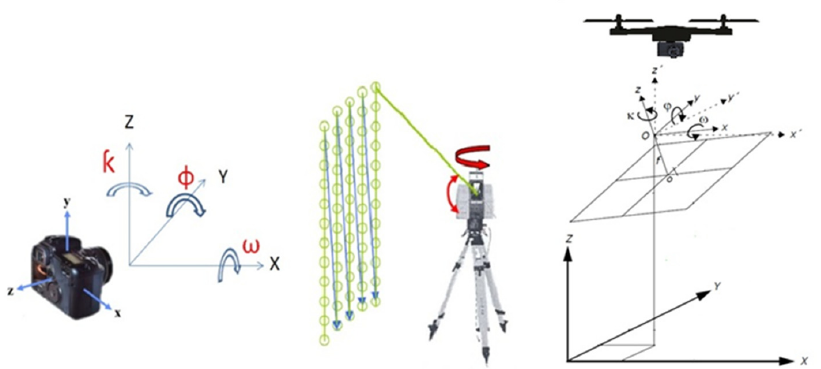
Figure 15. Camera registration parameters.